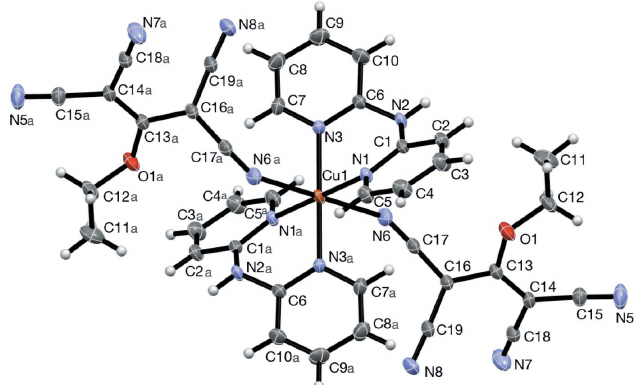
Figure 1 View of the title compound showing the atom-labelling scheme. Anisotropic displacement parameters of non-H atoms are drawn at the 30% probability level. [Symmetry code: ( a ) (cid:5) x + 1, (cid:5) y + 1, (cid:5) z + 1.]